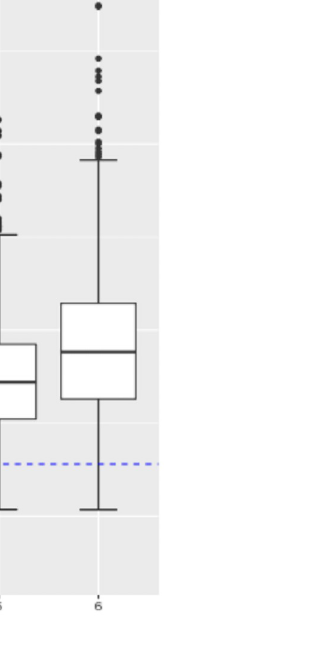
Fig 1. Cycle 1 posterior